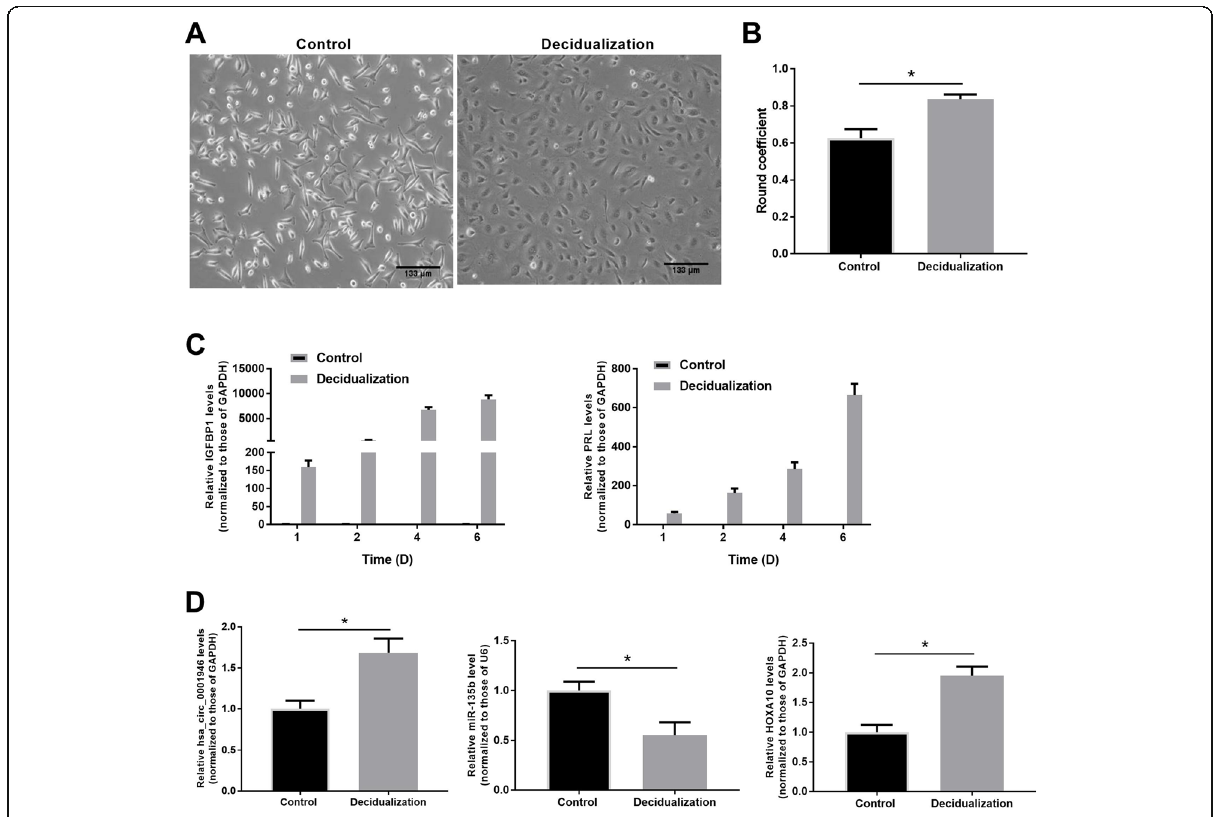
Fig. 4 Hsa_circ_001946 was elevated, miR-135b was decreased, and HOXA10 was elevated in decidual T-HESCs. T-HESCs were decidualized with 1 µM MPA and 0.5 mM 8-Br-cAMP hormone treatment. a . Cell morphology of T-HESCs under microscope. b. Image J software was used to analyze roundness coefficient of T-HESCs. c. Quantitative PCR for key decidualization related markers (IGFBP1 and PRL) in T-HESCs. d . Quantitative RT-PCR analyses for expression of hsa_circ_001946, miR-135b and HOXA10 in cells. * P <